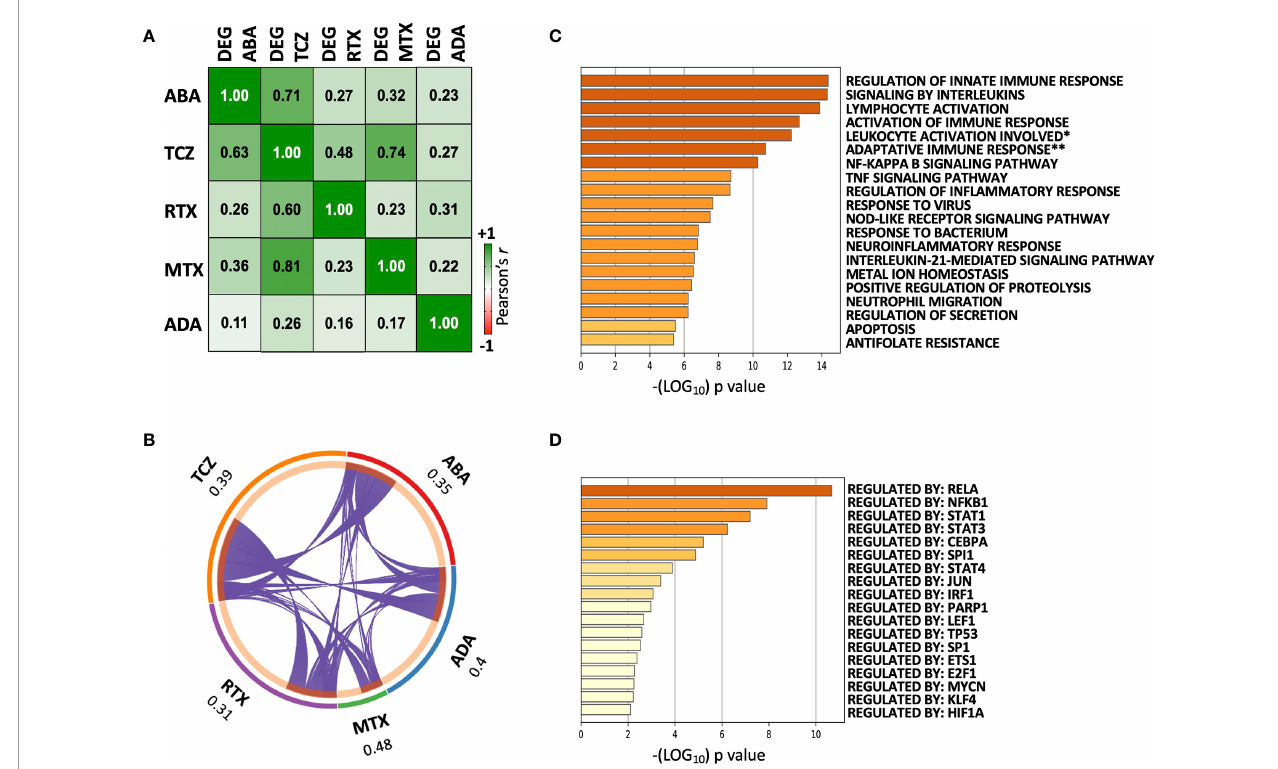
FIGURE 3 | Overlapping transcriptomic effects of fi ve DMARDs on paired pre/post-treatment RA synovial biopsies. (A) Correlation matrix showing Pearson ’ s r between mean Log 2 FCs induced by pairs of DMARDs. Cells show values for the differentially expressed genes of each DMARD (Columns: “ DEG ” ), vs . the modulation of these same transcripts by each of the other DMARDs (Rows). “ DEG ABA ” = 5824 transcripts signi fi cantly modulated by ABA between W0 and W16, “ DEG TCZ ” = 6726 transcripts, “ DEG RTX ” = 4577 transcripts, “ DEG MTX ” = 1228 transcripts, “ DEG ADA ” = 3383 transcripts. p < 10e -8 for all correlations. (B) Circos plot showing overlap between genes downregulated by each DMARD, and all other DMARDs. Each purple line joins a pair of shared genes. For each DMARD, the fraction of unique genes downregulated by at least one other DMARD is indicated. (C) Top 20 pathways identi fi ed by enrichment analysis of 227 genes downregulated by ≥ 3/5 DMARDs. Full pathway IDs: *Leukocyte activation involved in immune response, **Adaptive immune response based on somatic recombination of immune receptors built from immunoglobulin superfamily domains. (D) Transcription factor enrichment analysis of 227 genes downregulated by ≥ 3/5